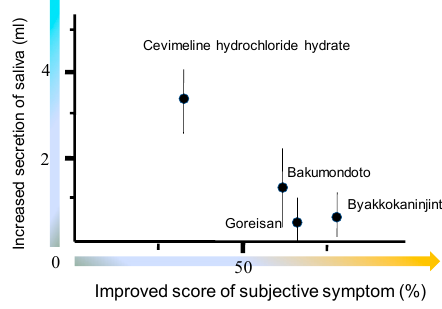
Figure 13. Regarding subjective symptoms, a questionnaire is issued about (i) mouth dryness, (ii) swallowing difficulty and (iii) oral pain, using the VAS method. When the average of these three items is 0, 1~20, 21~40, 41~60, 61~80, 81~100, the score is counted as 1, 2, 3, 4 and 5 points, respectively.